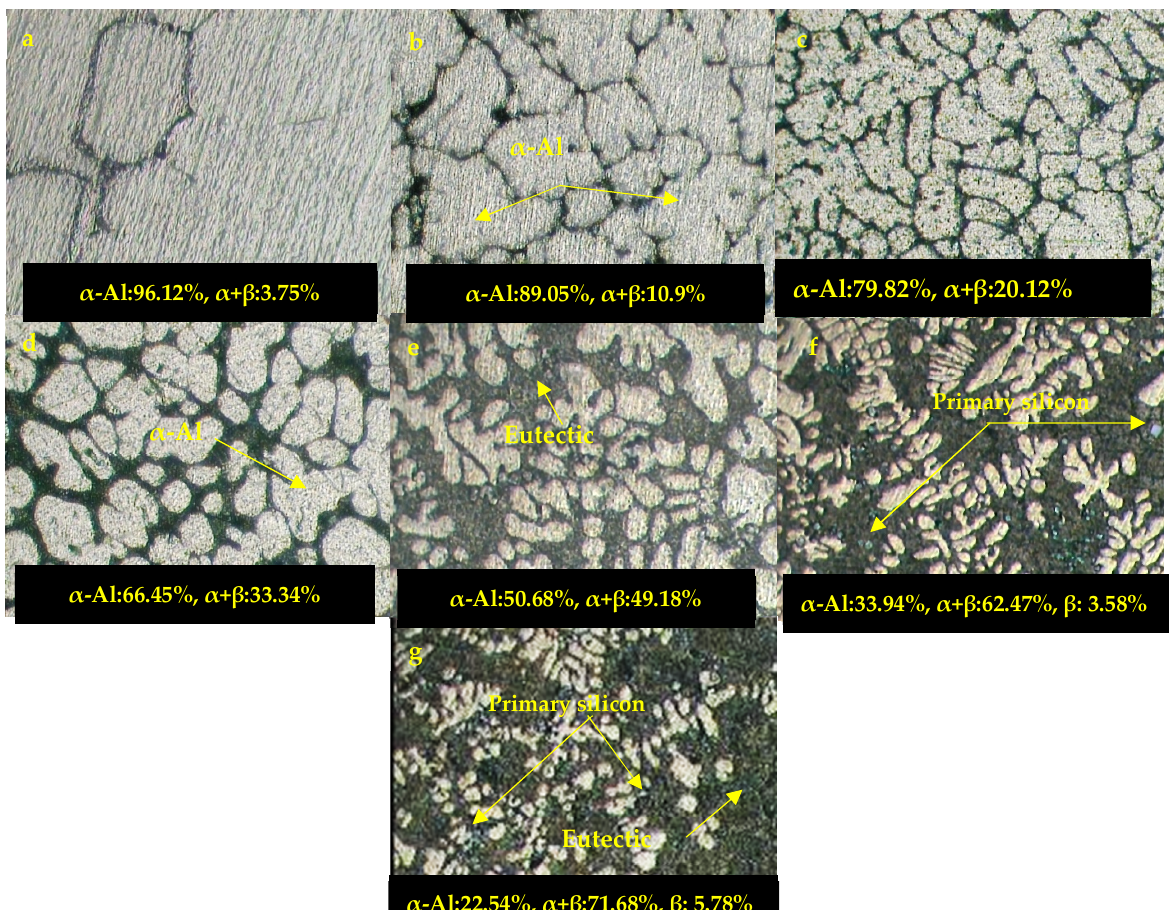
Figure 1. Optical images of different Al–Si alloys: ( a ) Al-1 wt.% Si (S1), ( b ) Al-3 wt.% Si (S3), ( c ) Al 5 wt.% Si (S5), ( d ) Al-7 wt.% Si (S7), ( e ) Al-9 wt.% Si (S9), ( f ) Al-11 wt.% Si (S11), and ( g ) Al-13 wt.% Si (S13). The images show the phase percent view obtained from MIP software.